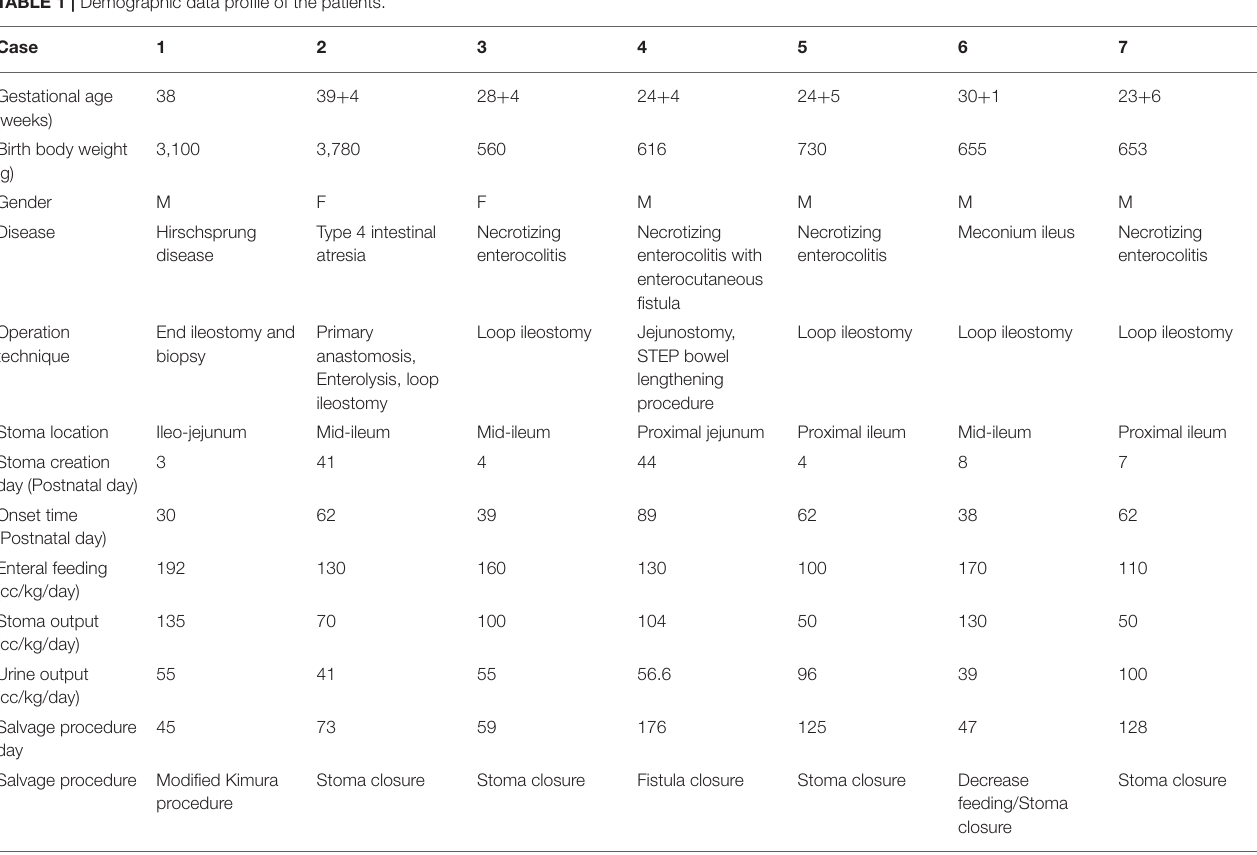
TABLE 1 | Demographic data profile of the